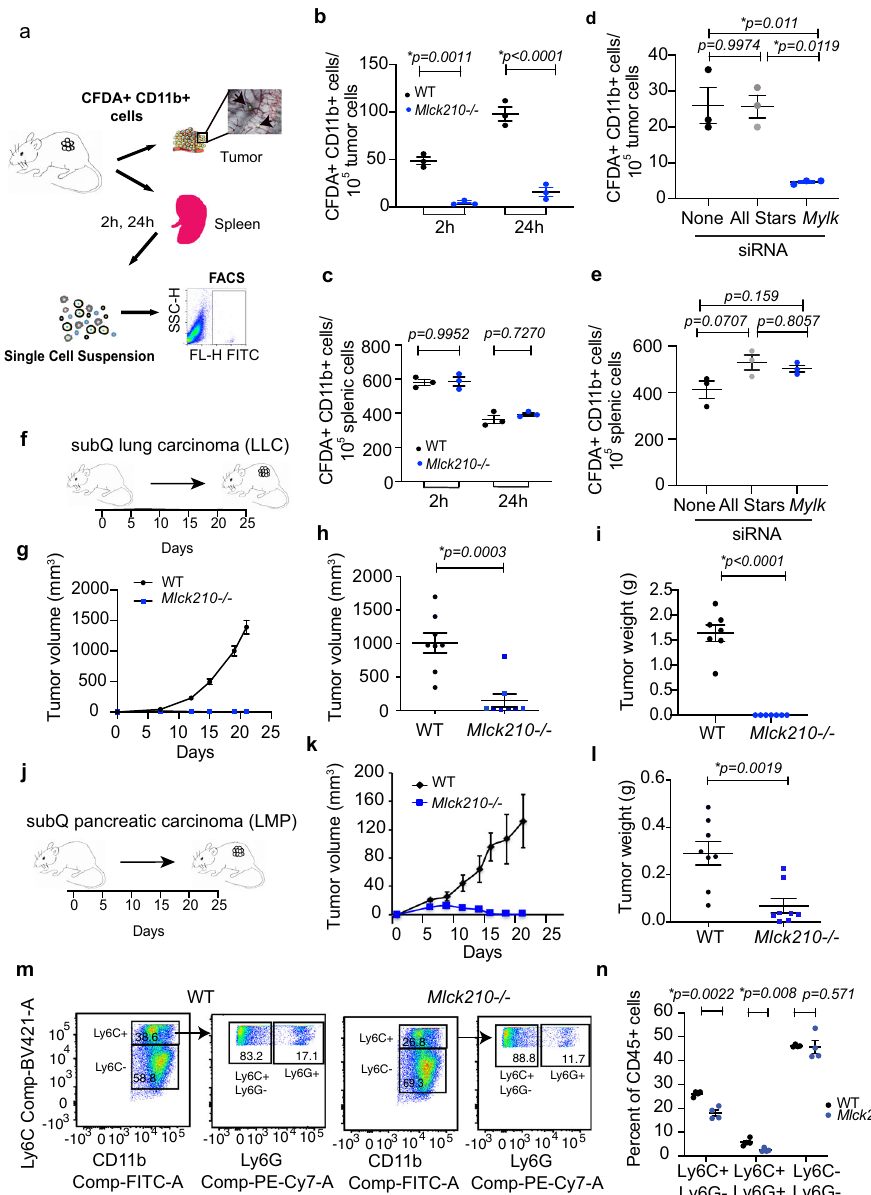
Fig. 6 MLCK210 deletion inhibits tumor in fl ammation and tumor growth. a Schematic of fl uorescent myeloid cell adoptive transfer into tumor bearing animals and method of analysis. Quanti fi cation of transferred cells was by single color fl ow cytometry. b Number of CFDA-labelled WT and Mlck210 − / − CD11b + cells in tumors 2 h or 24 h after adoptive transfer into mice ( n = 3 mice), * p = 0.0011 2 h and * p < 0.0001 24 h WT vs Mlck210 − / − by t -test. c Number of CFDA-labelled WT and Mlck210 − / − CD11b + cells in spleens 2 h or 24 h after adoptive transfer into mice ( n = 3 mice), p = 0.9952 2 h and p = 0.727 24 h WT vs Mlck210 − / − by t -test. d Number of CFDA-labelled control All Stars and Mylk siRNA-transfected CD11b + cells in tumors 2 h